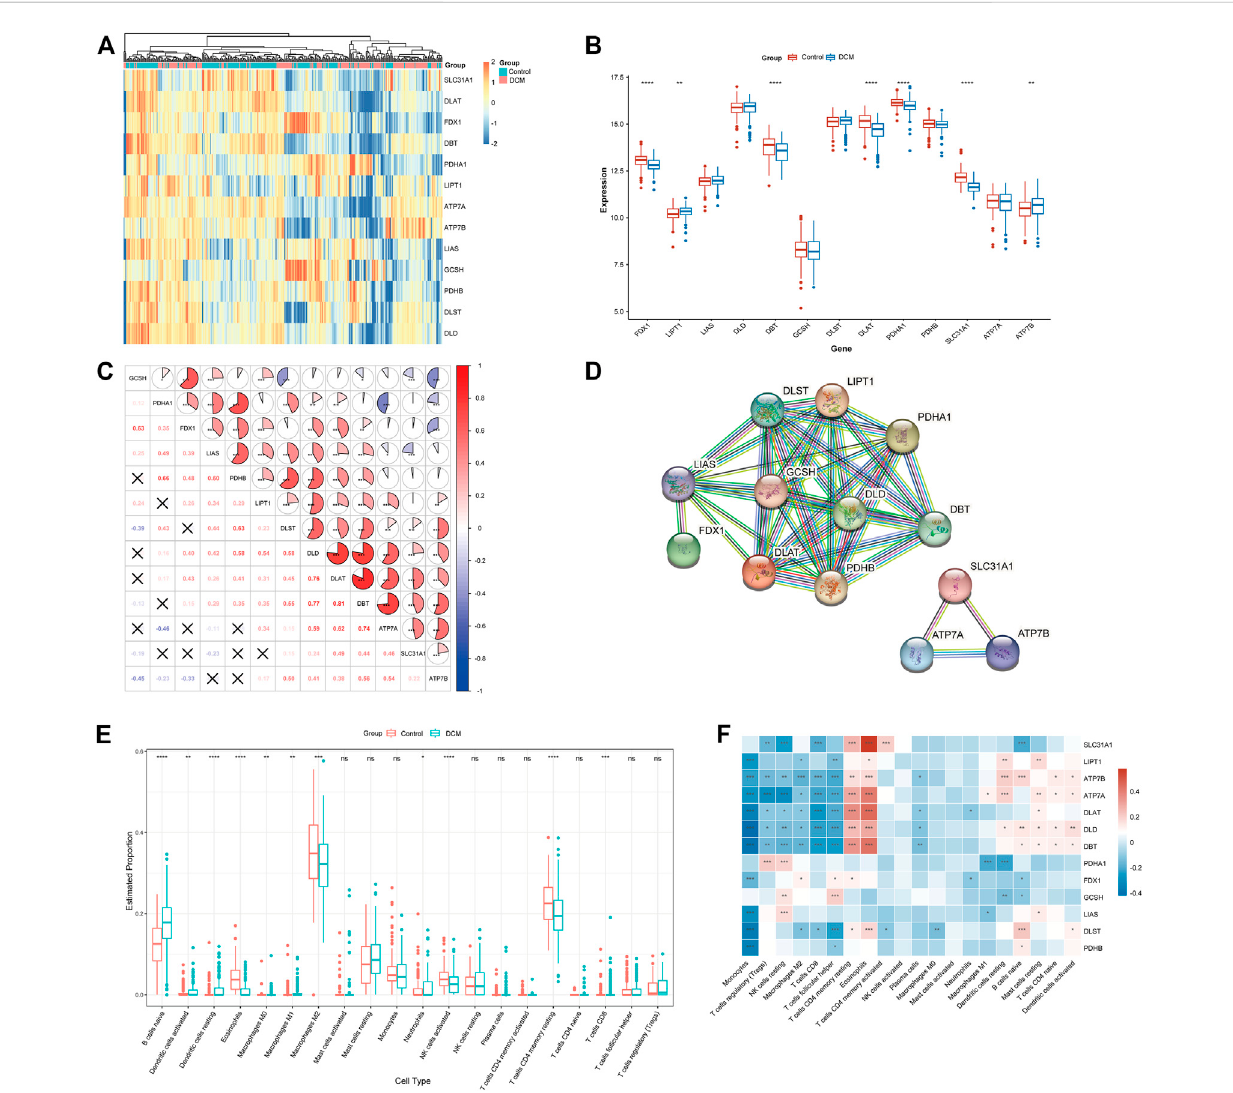
the expression of 13 CRGs. (B) Boxplots showing the expression of the 13 CRGs between DCM and healthy controls. * p < 0.05, *** p < 0.001, **** p < 0.0001, ns, not signi fi cant. (C) Correlation analysis among the 13 CRGs. Red and blue represent positive and negative correlations. The area of the pie chart indicates the correlation coef fi cient. * p < 0.05, *** p < 0.001, **** p < 0.0001. (D) PPI network diagram of the CRGs. (E) Boxplots showing the difference in immune in fi ltration between DCM and healthy controls. * p < 0.05, *** p < 0.001, **** p < 0.0001, ns, not signi fi cant. (F) Correlation analysis between CRGs and in fi ltrating immune cells. Red and blue represent positive and negative correlations. * p < 0.05, *** p < 0.001, **** p <